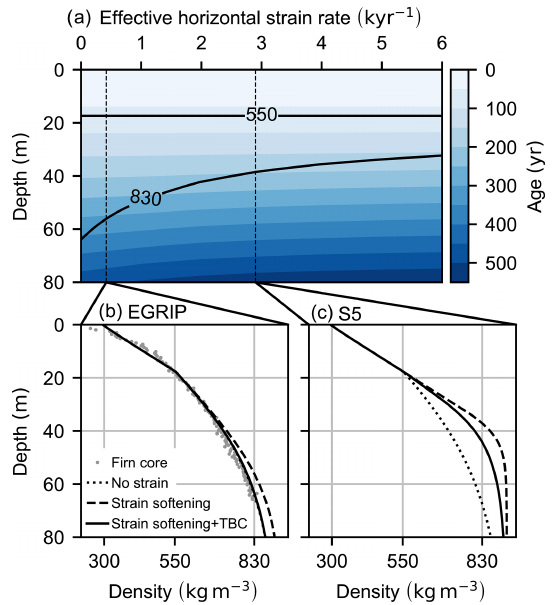
Figure 2. (a) Study of the decreasing sensitivity of firn densification to strain softening for increasing effective horizontal strain rates for climatic conditions present at EGRIP. The background shows the age contours, and the black lines indicate the critical depth and the depth of the firn–ice transition. Vertical dashed lines indicate the backtraced mean effective horizontal strain rate at the firn core sites in (b) and (c) . (b) Firn density data of the NEGIS firn core at EGRIP (Vallelonga, 2012; Vallelonga et al., 2014) and its model with no strain, strain softening and additionally the tuning bias correction (TBC) being applied. (c) The same model outputs for the S5 2019 shear margin firn